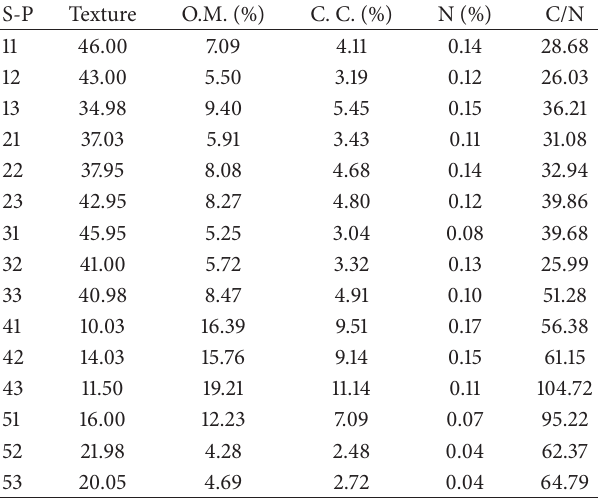
Table 4: Values of soil variables in fifteen sampling sites of the Tamaulipan thornscrub forest.